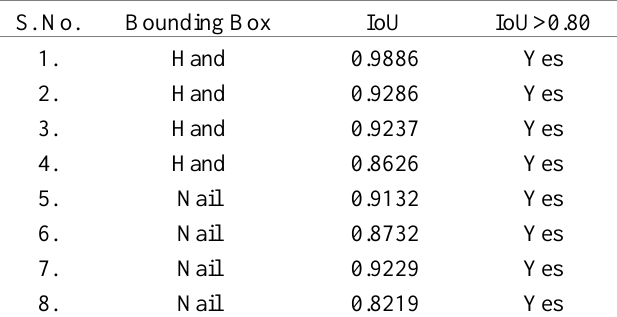
IoU values, considering an IoU threshold = 0.8